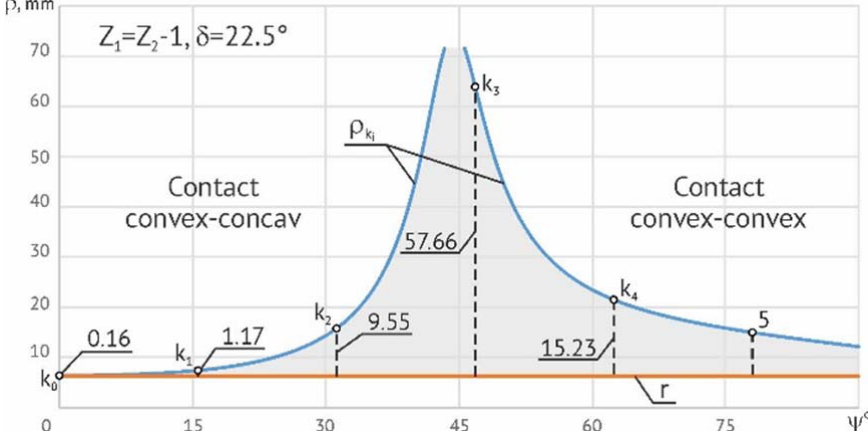
Figure 5 . The difference of the curvature radii (  wheel  and of the satellite r in the contact k